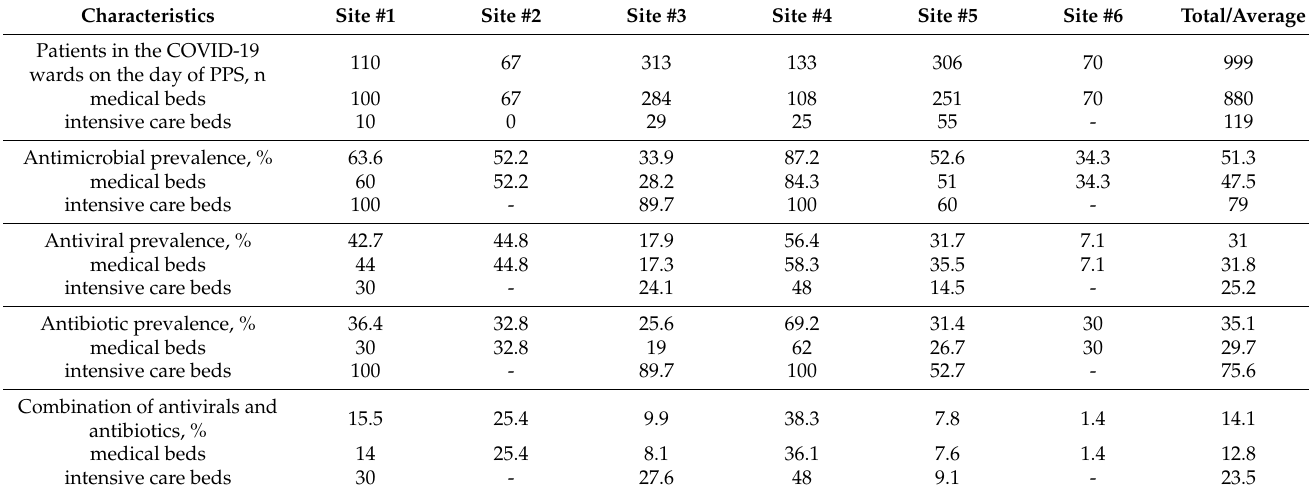
Table 2. AMD use prevalence * in patients in COVID-19 wards on the day of